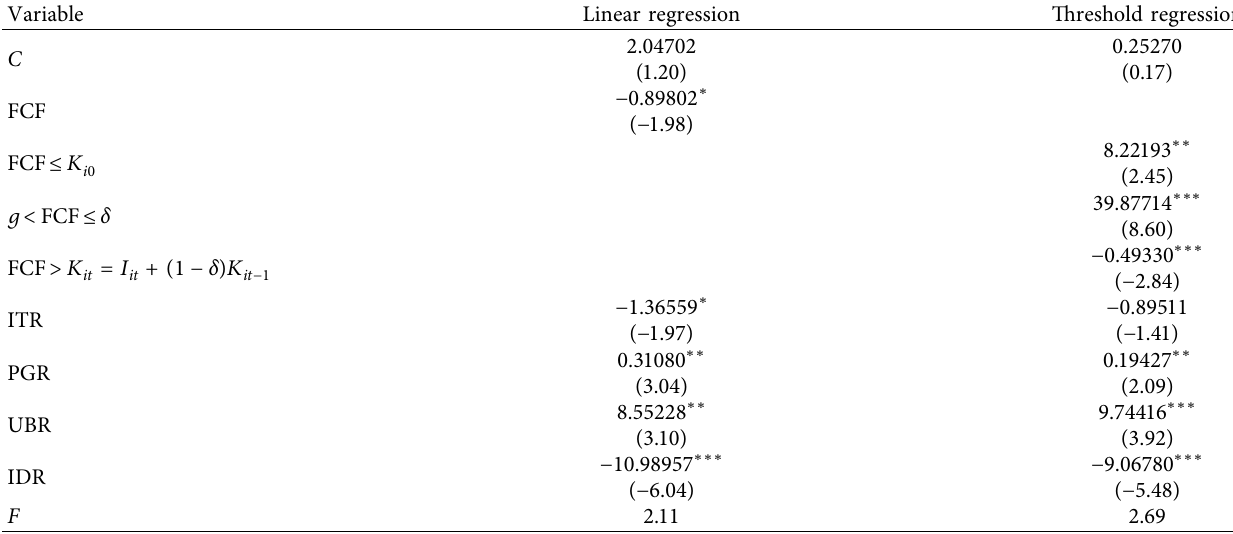
Table 7: Parameter estimation results with financial system as threshold